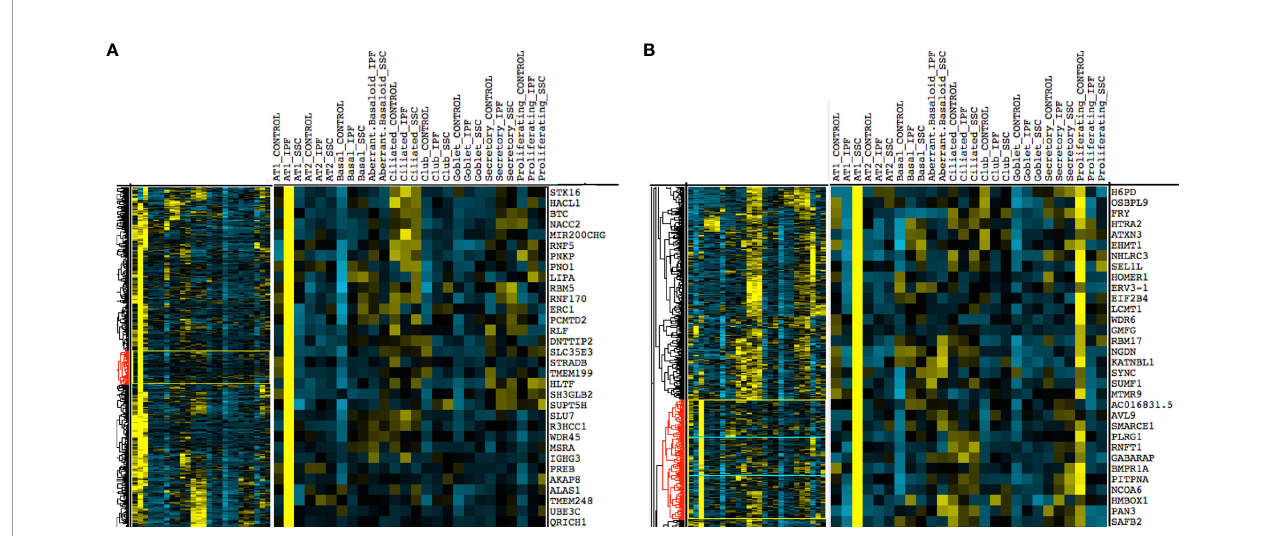
FIGURE 6 | Hierarchical clustering on gene average expression levels of epithelial cell subtypes divided by disease status, demonstrating distinct gene signatures of IPF and SSc-ILD AT1 cells. Yellow indicates positive and blue indicates negative scaled expression. (A) Partial gene signature of IPF AT1 cells (B) Partial gene signature of SSc-ILD AT1 cells. IPF, idiopathic pulmonary fi brosis; SSc-ILD, systemic sclerosis-associated interstitial lung disease; AT1, alveolar type 1; AT2, alveolar type